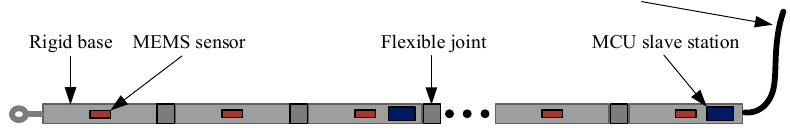
Figure 1. Microelectromechanical sensor (MEMS) array structure.